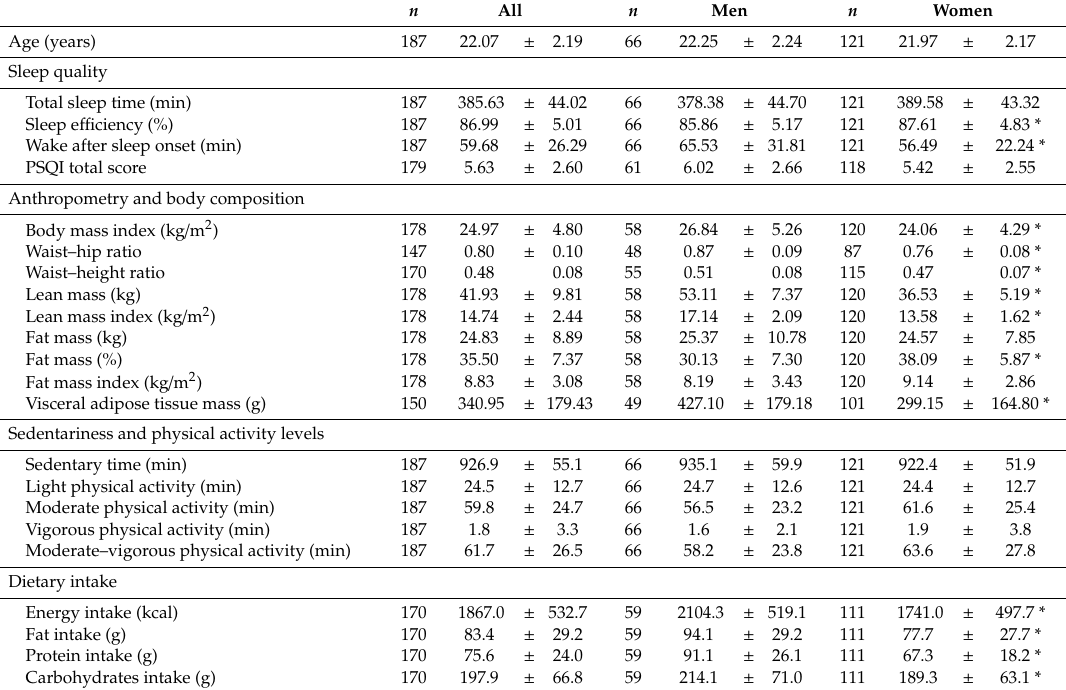
Table 1. Descriptive characteristic of